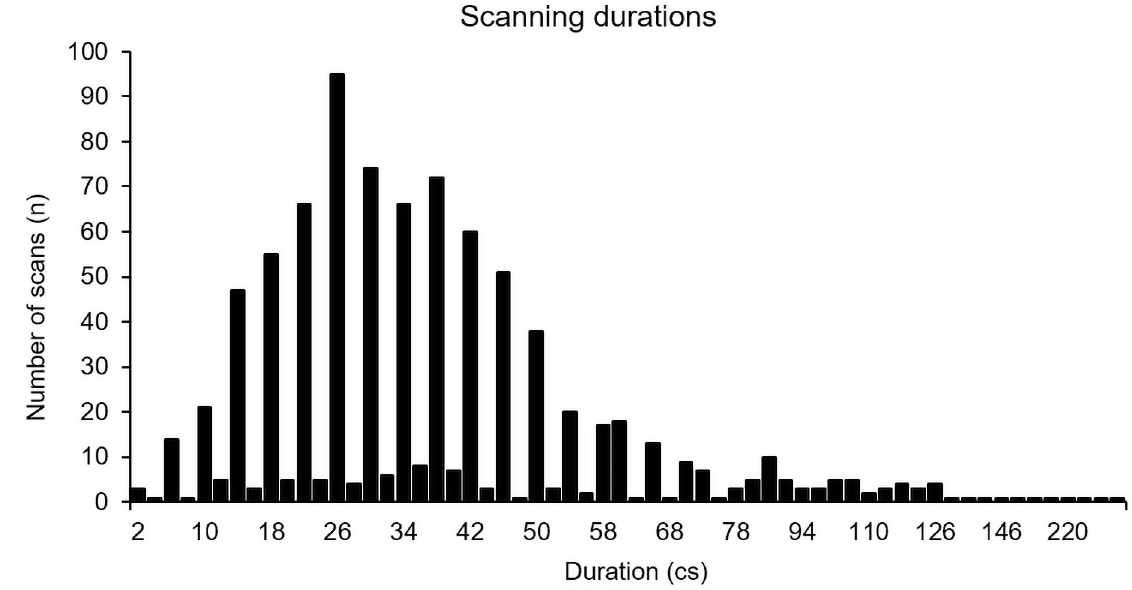
PLOS ONE | https://doi.org/10.1371/journal.pone.0244118 August 20,